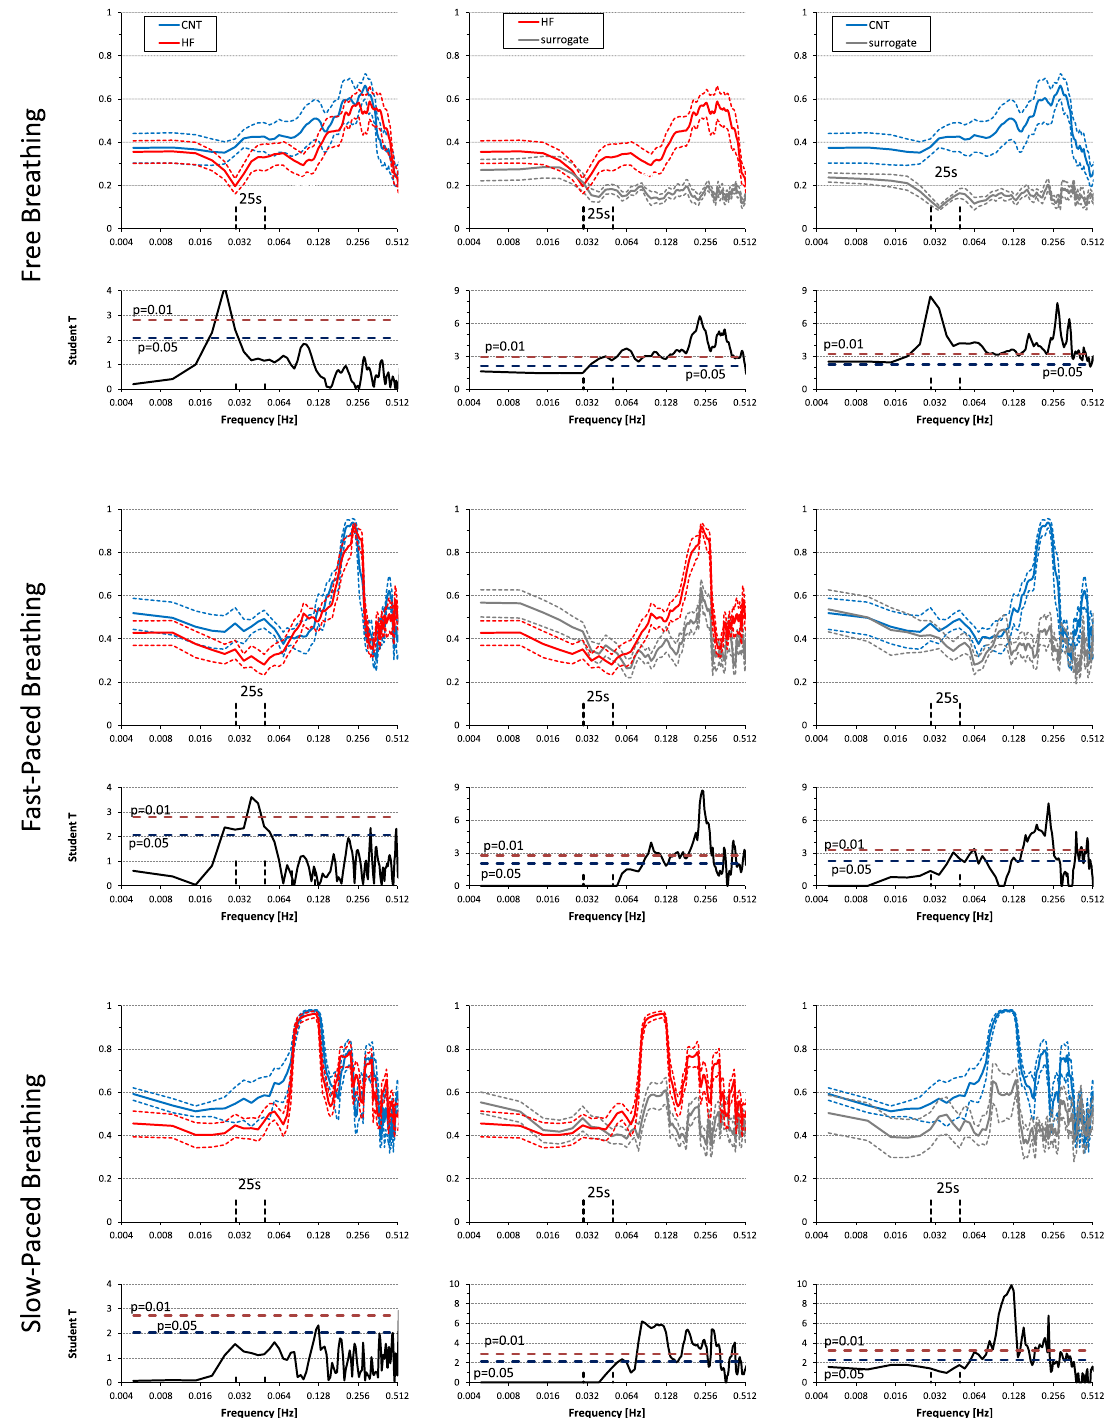
Figure 6. RSP–RRI coherency spectra during free, fast-paced, and slow-paced breathing. Spectra as mean ± sem, with Student T between groups. Left panels compare heart failure (HF) patients and controls (CNT): T-values above the dashed lines point out significant differences between groups. Central panels compare original and surrogate coherency spectra in the HF group while right panels compare original and surrogate coherency spectra in the CNT group: T-values above the dashed lines point out coherences significantly greater than